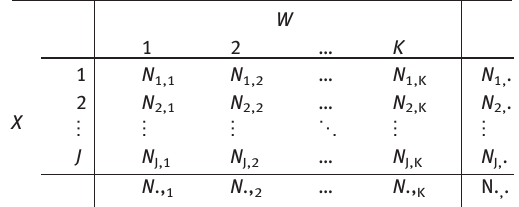
Table 1: Single categorical covariate : For the case of one categorical covariate, the contingency table summarizes the distribution of the covariate in each level of the treatment. For a completely randomized design, a natural covariate balance function is the matrix of internal cells.